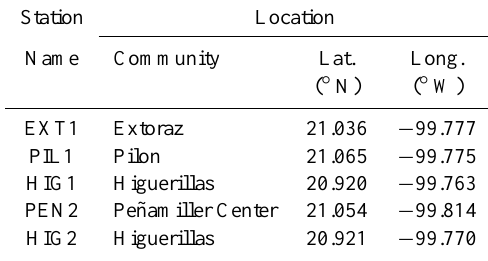
Table 1b. Station location.